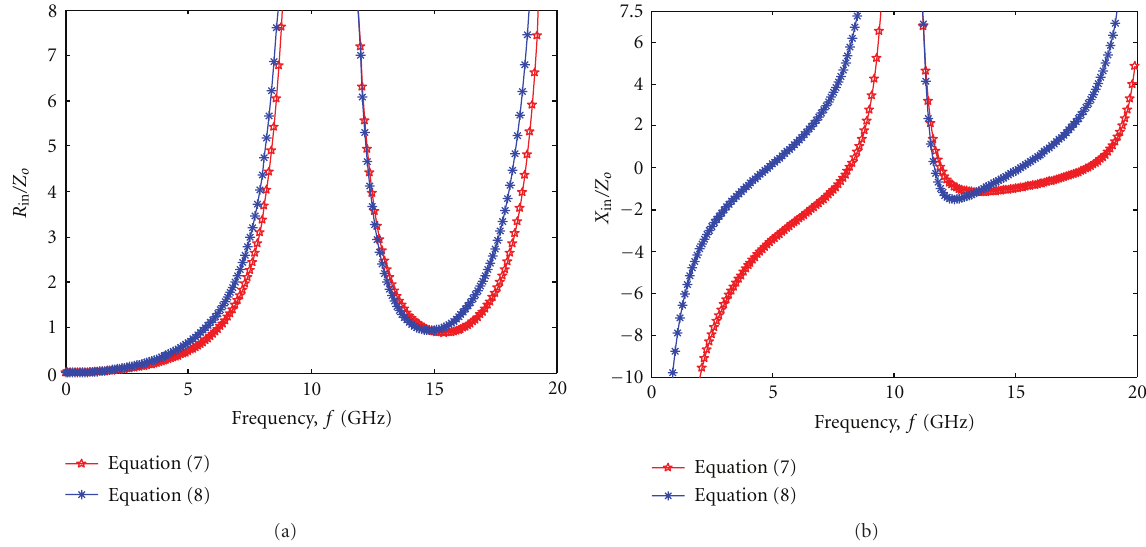
Figure 3: Comparison of calculated normalized resistance, R in /Z o , and normalized reactance, X in /Z o , for air at 25 ◦ C using (7) and (8) ( a = 0 . 65 mm, b = 2 . 05 mm, and h = 14 . 32 mm).